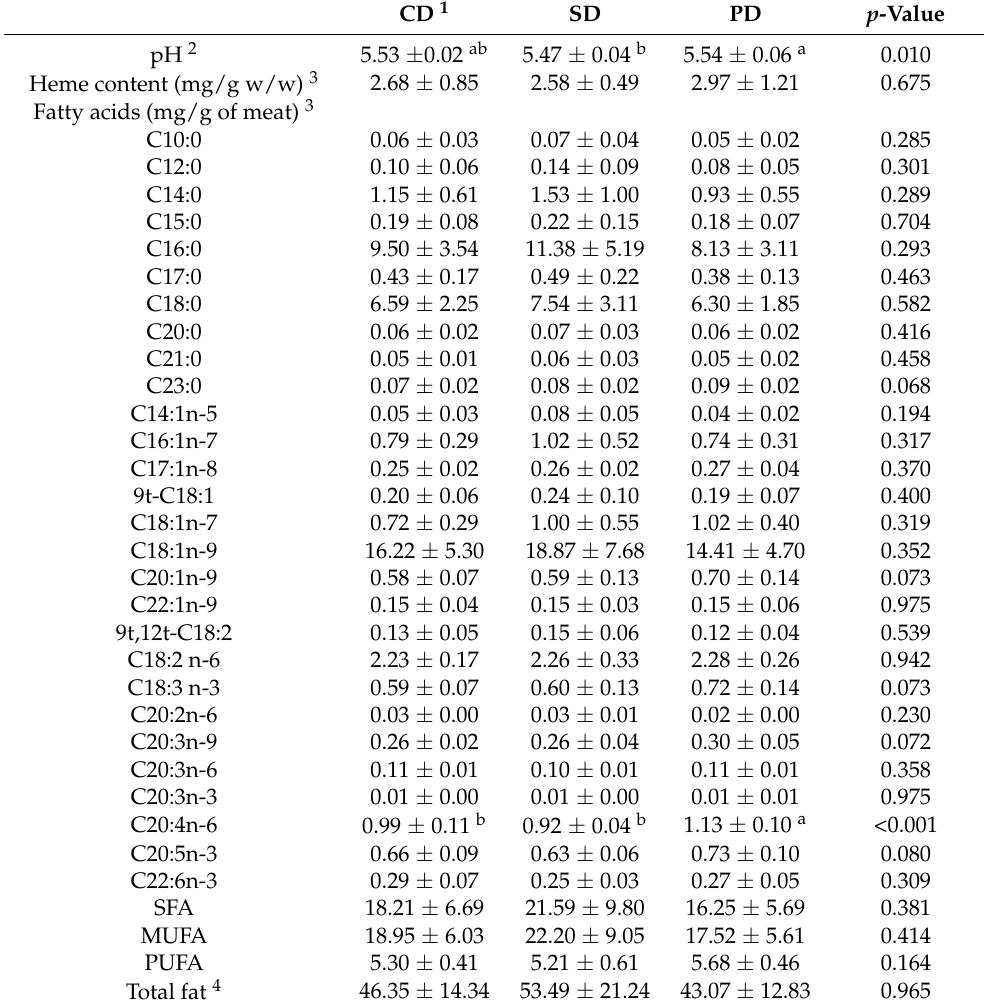
Table 2. pH, heme content, and fatty acid profile of raw meat from lamb fed three finishing diets. Results are presented as mean ± STD ( n =